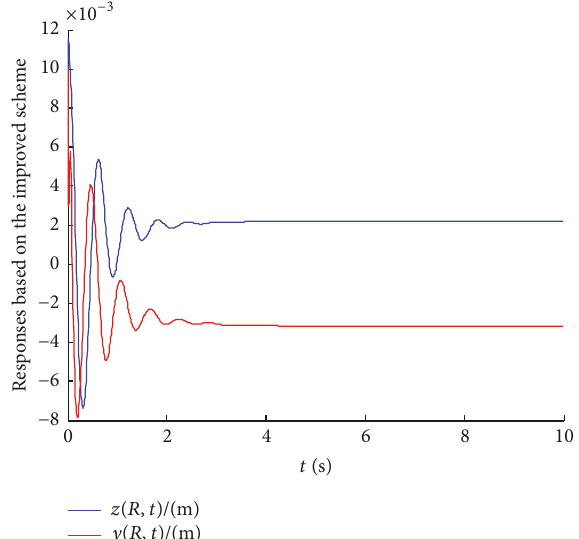
Figure 11: Responses based on the improved scheme.